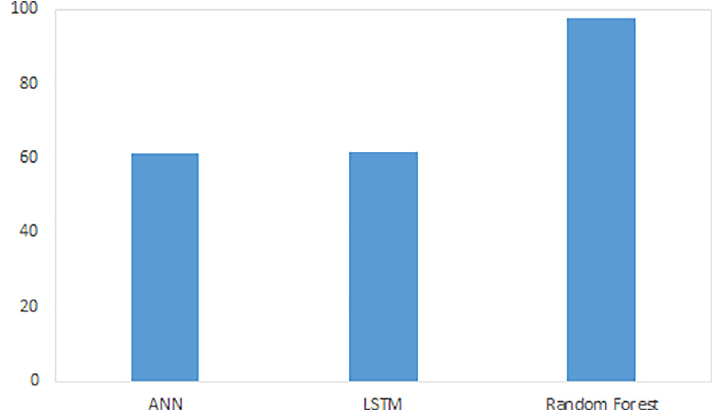
Figure 1. Accuracy of ML